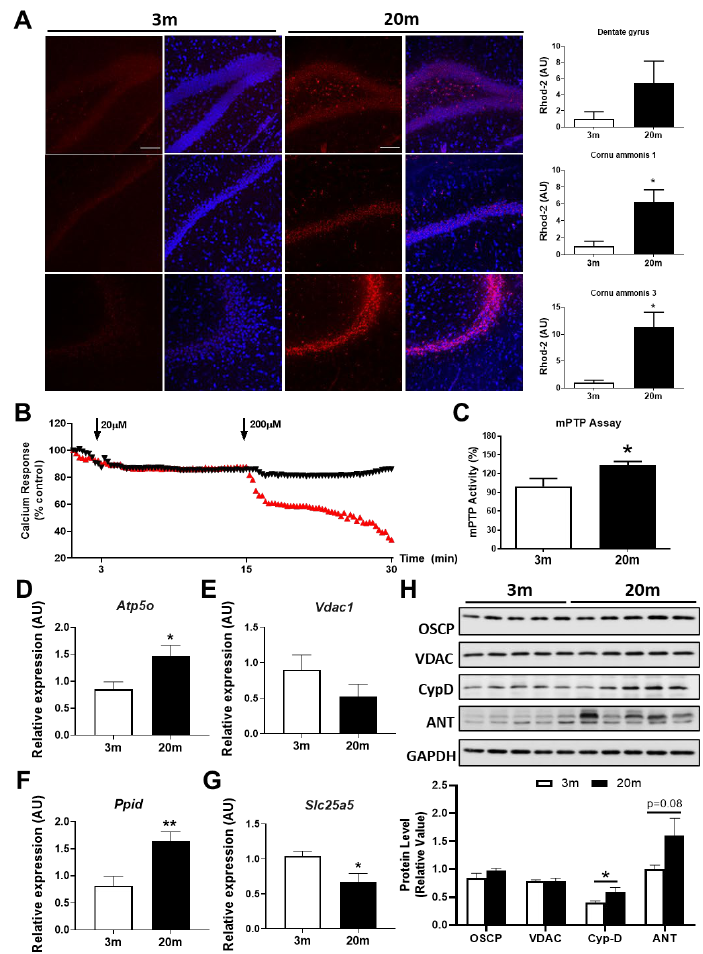
Figure 3. Hippocampal aging of female C57BL/6J mice is associated with increased mitochondrial calcium levels and reduced calcium buffering. ( A ) Representative images of non-fixed